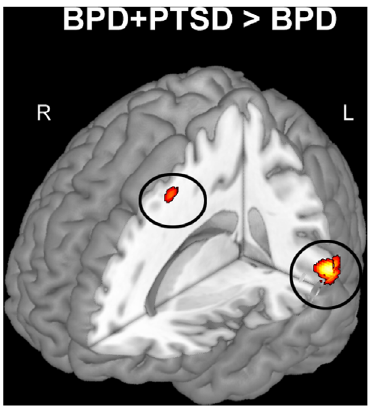
Figure 2. Whole-brain maps illustrate smaller gray matter volumes in patients with borderline personality disorder (BPD- PTSD) compared to patients with borderline personality disorders and co-occurring PTSD (BPD + PTSD). For visualization purposes, the statistical maps were thresholded at T . 2.5. Size and location of clusters are reported in Table 1 and